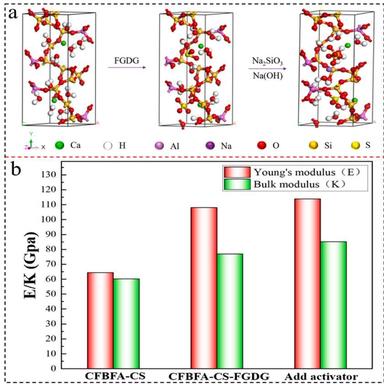
Structure model and calculation of composite cementitious system (a: unit cell structure of composite system b: modulus value of composite system).